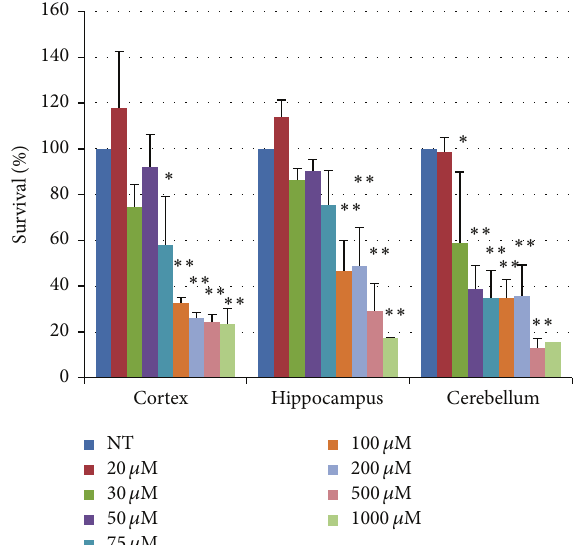
Figure 2: Cell survival as detected by the MTT assay in neurons from different brain regions treated with increasing H 2 O 2 doses for 30 min. Error bars indicate the standard error. ∗ 𝑝 < 0.05 and ∗∗ 𝑝 < 0.01 versus untreated (NT) by Least Significant Difference (LSD)test.Two-wayANOVAdidnotshowanysignificantdifference in the response to treatment in the neurons derived from the three different brain regions (cell cultures were prepared as previously described) [137–139]. In more detail, C57BL wild-type mice were sacrificed at postnatal day 5 (P5) for cerebellar granule cell cultures, whereas at day 17 embryos were collected from pregnant mice for preparation of cortical and hippocampal neurons. Brain regions were dissected and dissociated and cultures were maintained in appropriate